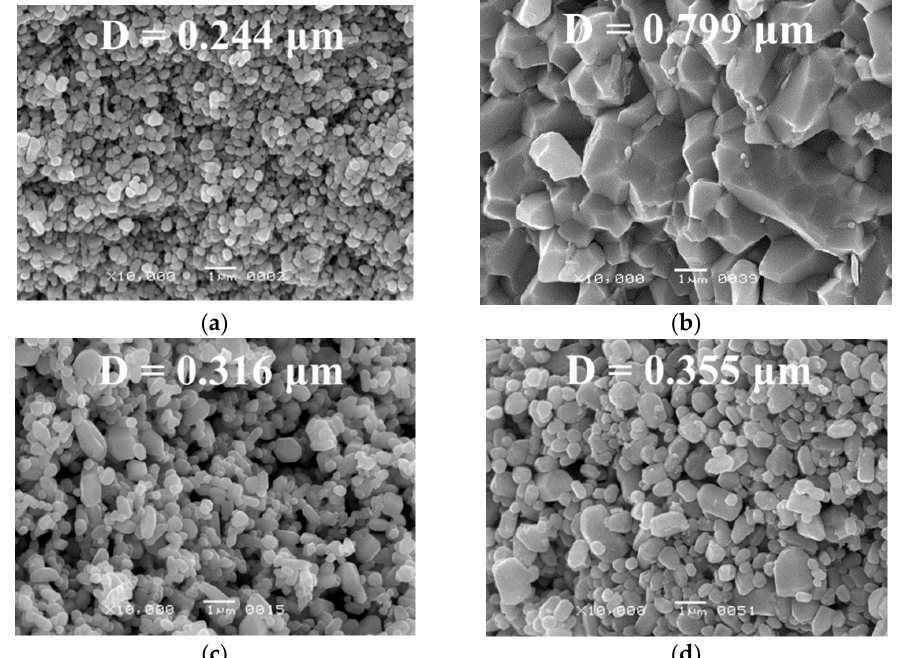
Figure 4. Microstructure of samples obtained in an acetate medium: ( a ) CSP1 sample (0.185 mol% Zn(Ac) 2 ); ( b ) CSP2 sample (0.927 mol% Zn(Ac) 2 ) (Reprinted from Ref. [33], copyright (2019), with the kind permission of Springer Nature.); ( c ) TVT1 sample (0.185 mol% Zn(Ac) 2 ); ( d ) TVT2 sample (0.927 mol% Zn(Ac) 2 ).